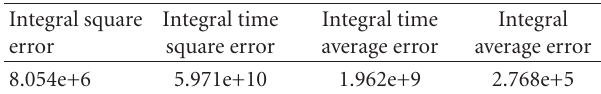
Table 2: Minimum setting values of ISE, ITSE, ITAE, and IAE. Integral square